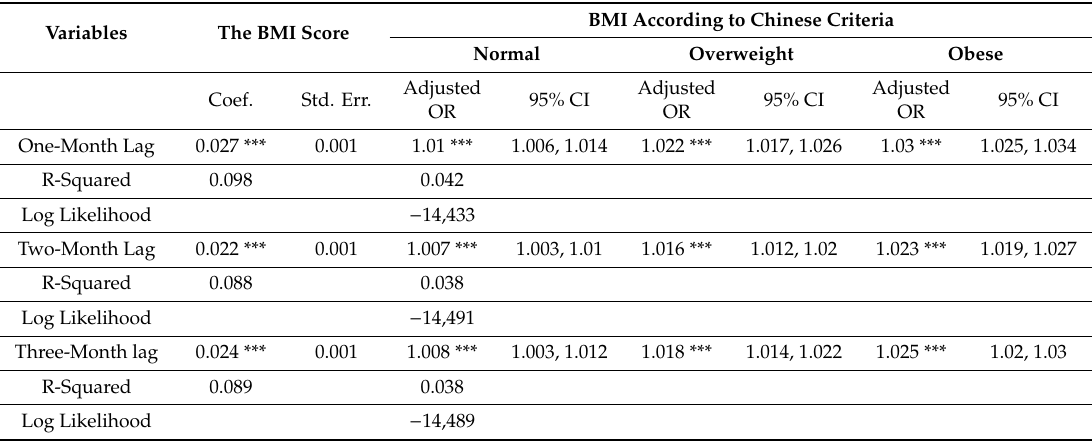
Table 7. E ff ect of Air Quality Index (AQI) on Body Mass Index (BMI): AQI